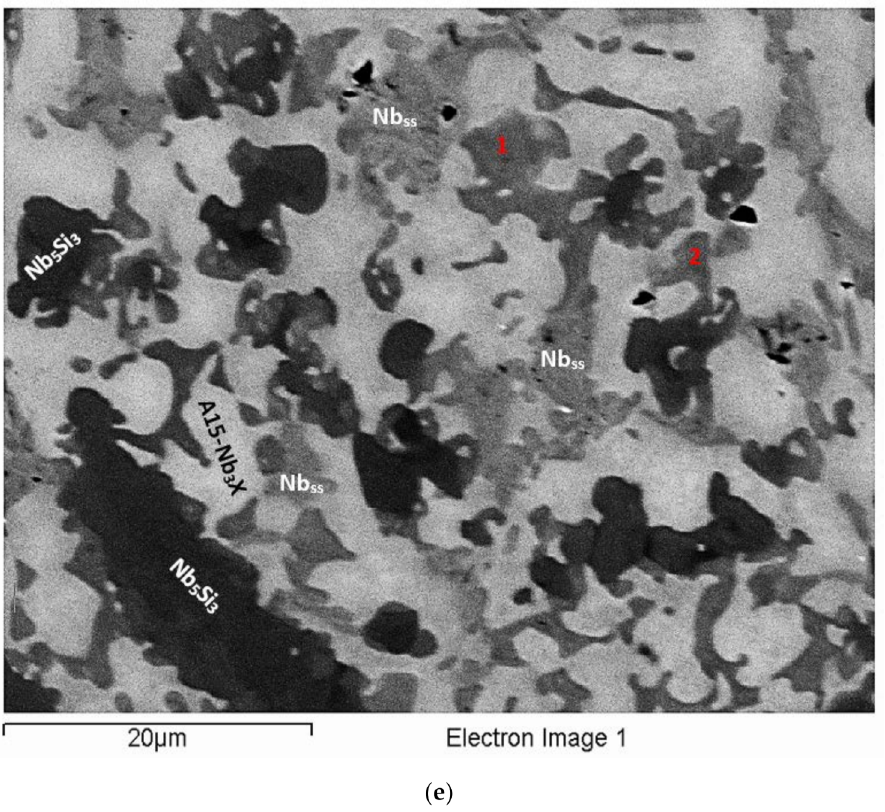
Figure 3. BSE images of EZ5-AC: ( a ) top, ( b ) and ( c ) bulk, and ( d ) and ( e ) bottom of the ingot. Note that contrast has been enhanced in ( a , b , d , e ) to show different phases, in particular the Nb ss and the Hf-rich Nb 5 Si 3 (numbers 1, 2 in ( e )). See text for